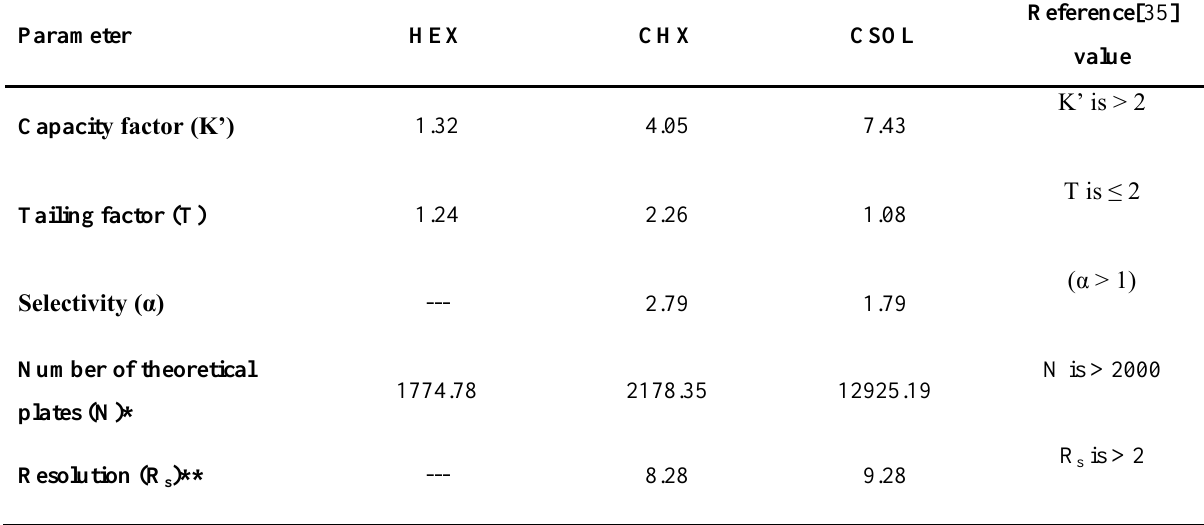
Table 5. System suitability parameters of the proposed HPLC method for determination of HEX, CHX & CSOL in pure